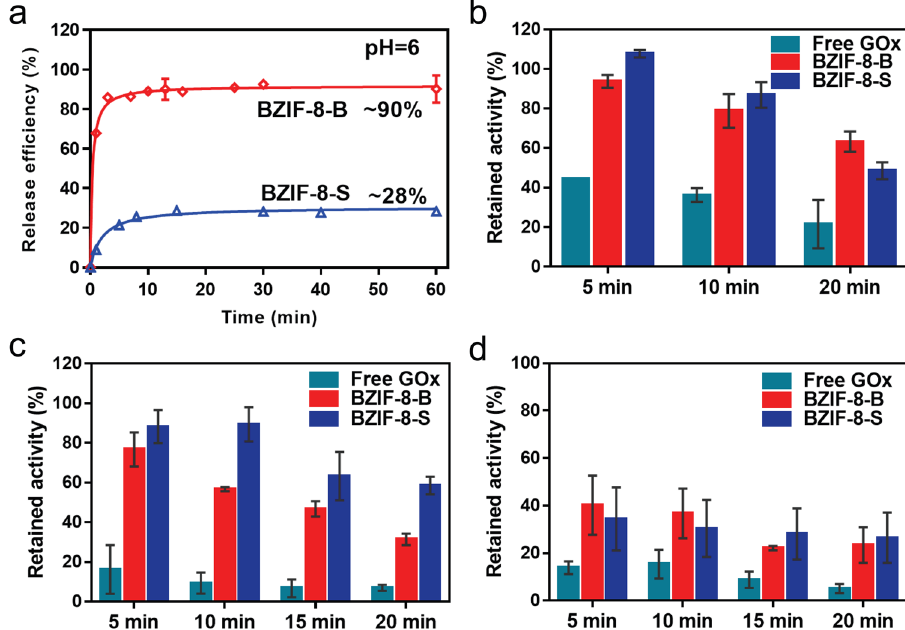
Fig. 6 Structure-dependent stability and protecting effect. a The time-dependent release of proteins of BZIF-8-B and BZIF-8-S at pH = 6 PBS. Error bars = Standard Deviation ( n = 3). The retained activities of free GOx, BZIF-8-B, and BZIF-8-S after heating ( b ), 10 M urea ( c ) and acetone ( d ) treatment for different times. Error bars (SD) are presented in each group. Error bars = Standard Deviation ( n =